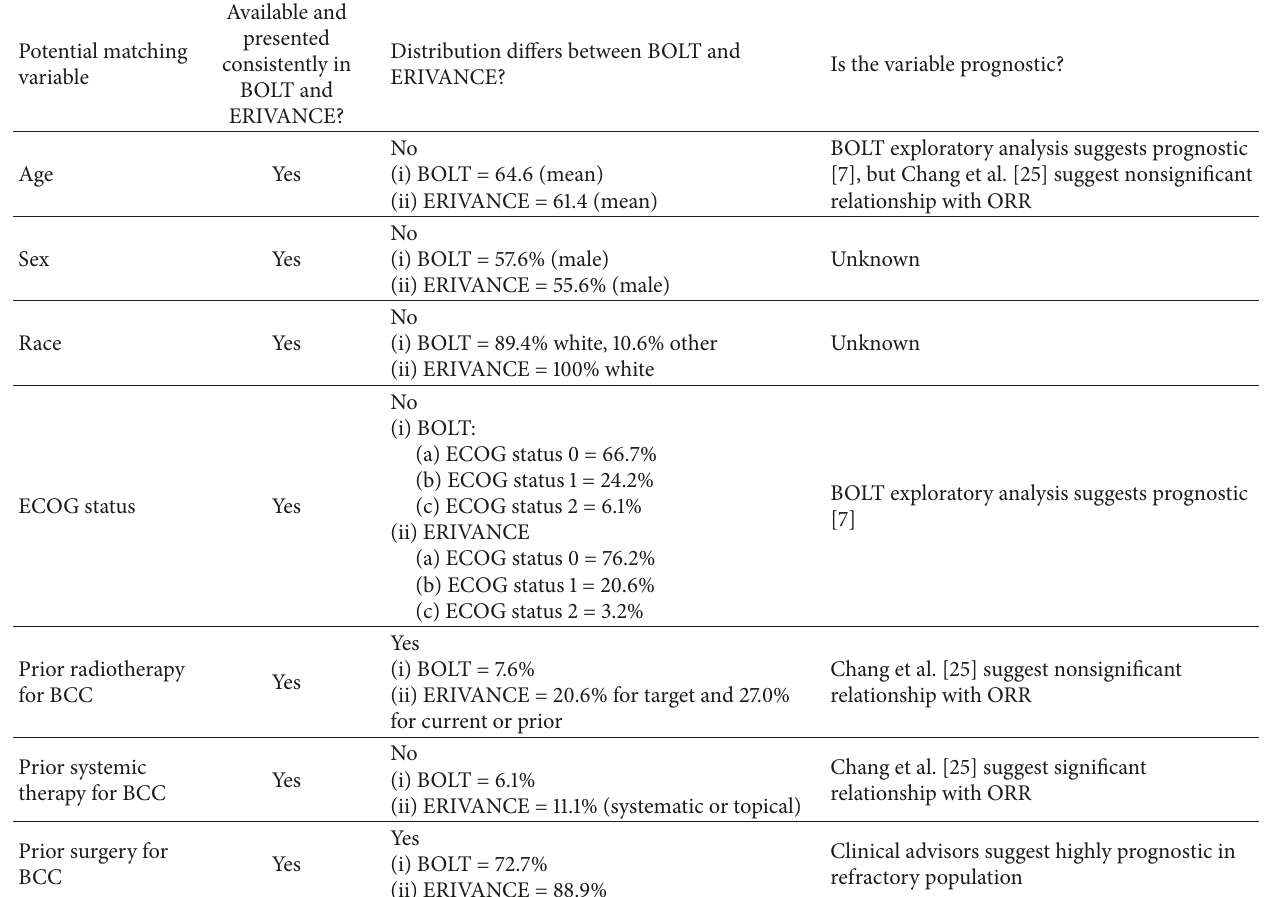
Table 2: Overview of trial patient baseline characteristics.